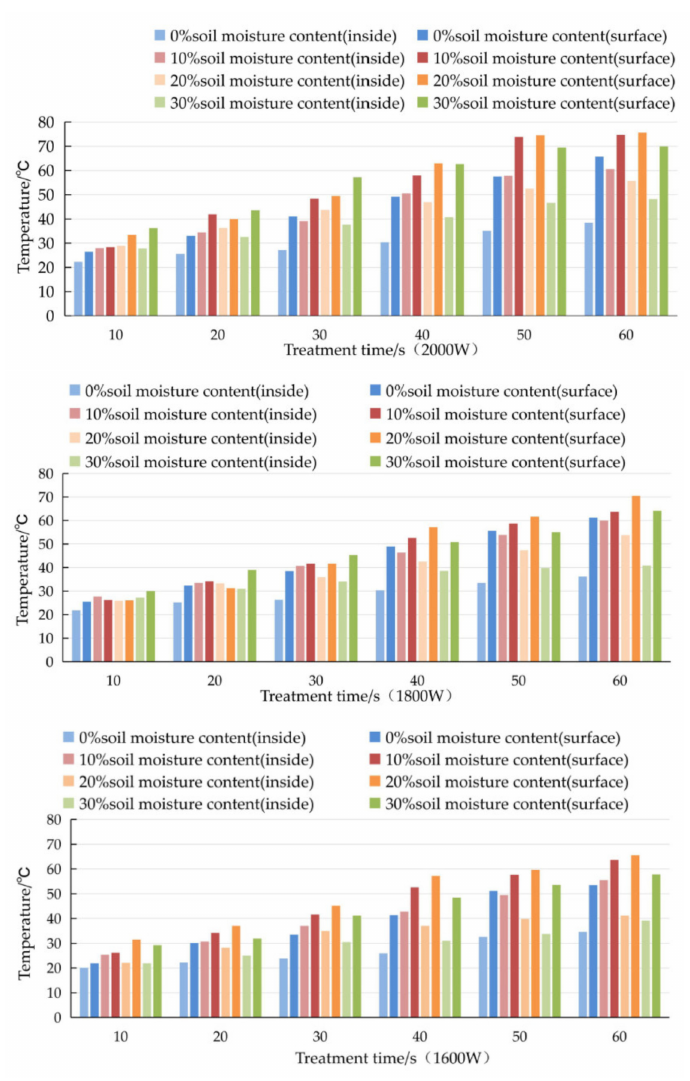
Figure 24. Maximum internal soil temperature and soil surface